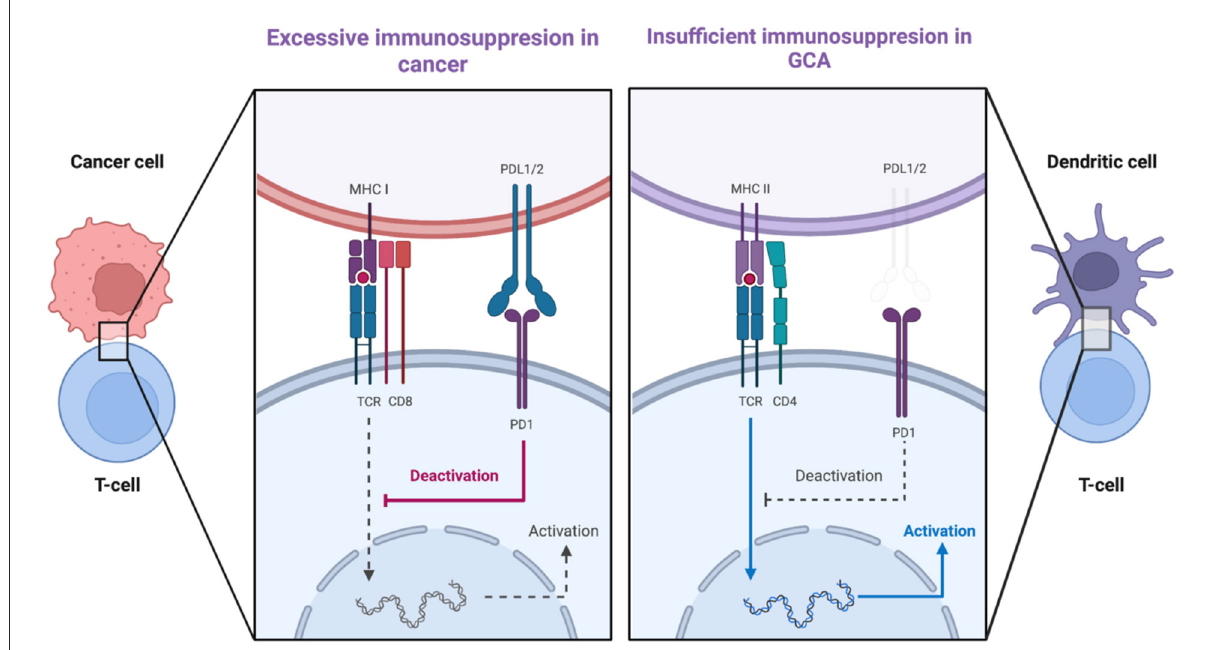
FIGURE4 PDL1-PD1 checkpoint dysregulation in cancer and in giant cell arteritis. The expression of PDL1 on cancer cells delivers immunoinhibitory signals to T-cells and thus cancer cells evade tumor surveillance. In GCA, there is low expression of PDL1 on vascular dendritic cells whereas most T-cells arriving in the artery are PD1-positive. Created with BioRender.com. Adapted from “T-cell Deactivation vs. Activation.” Retrieved from